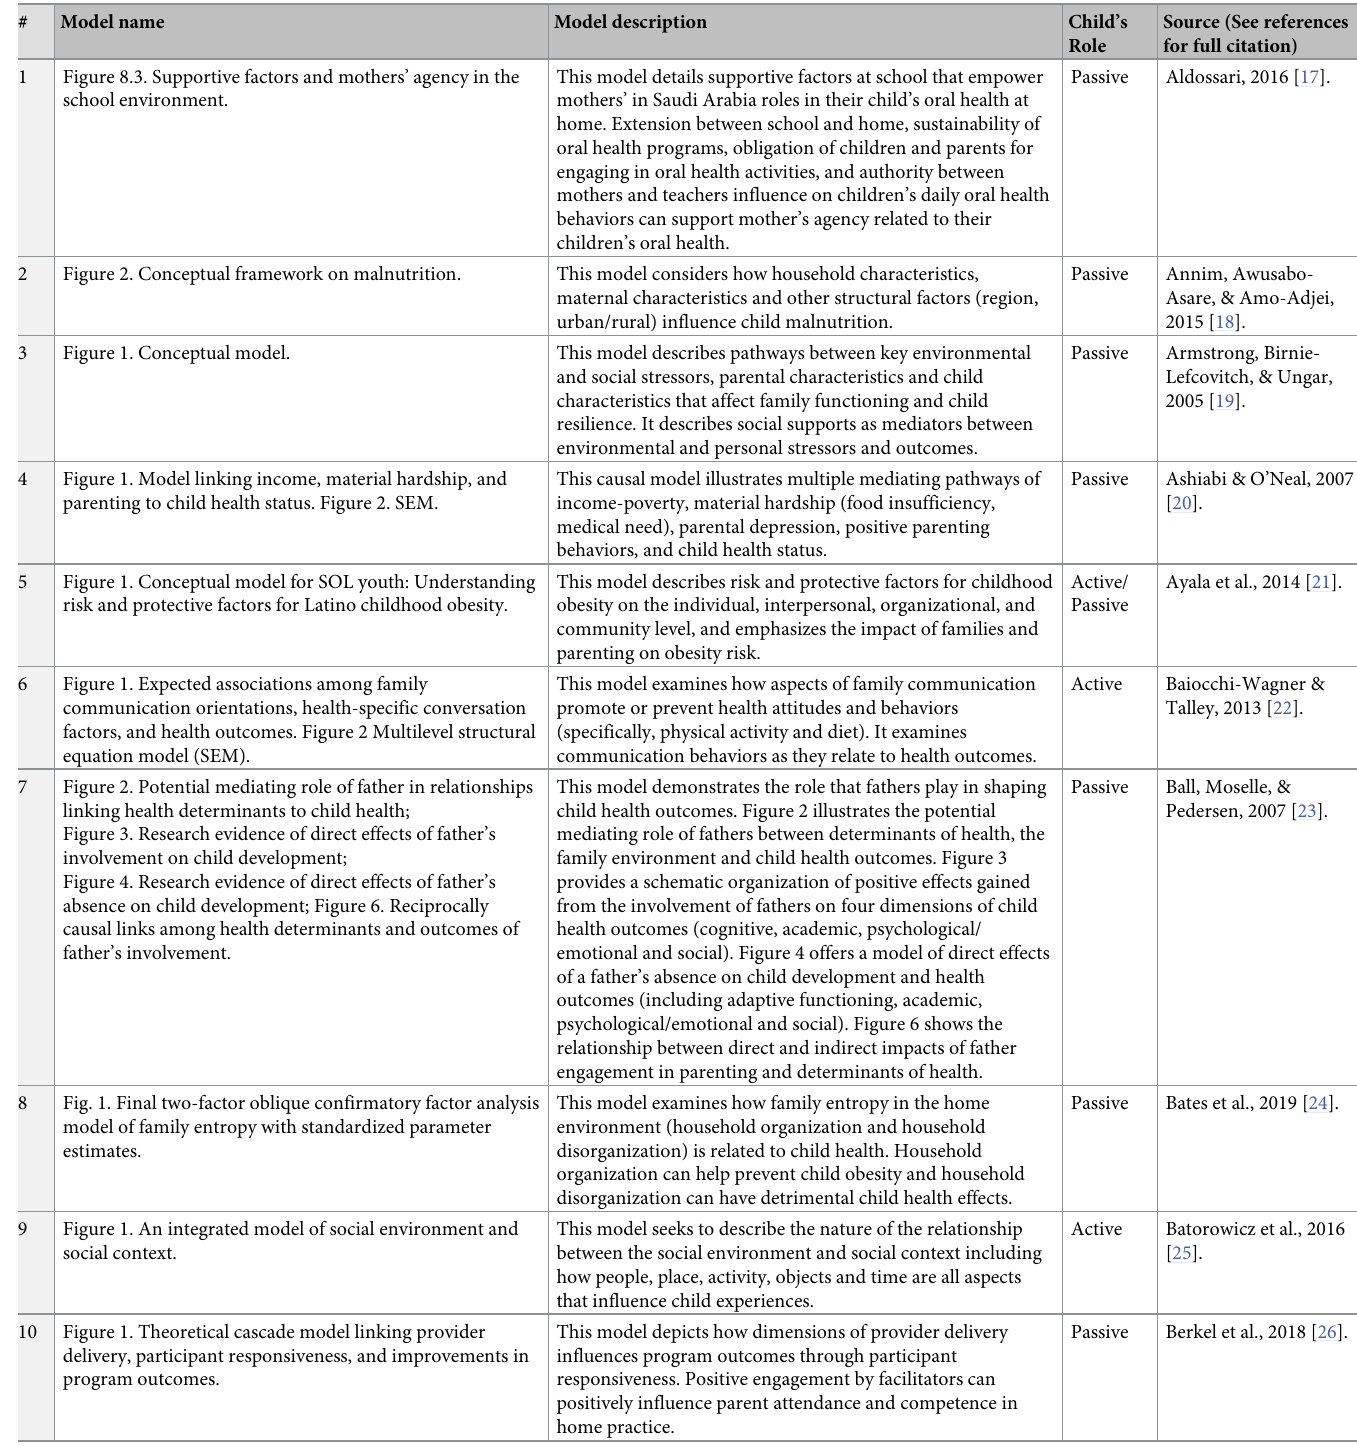
Table 1. Summary table of identified models.